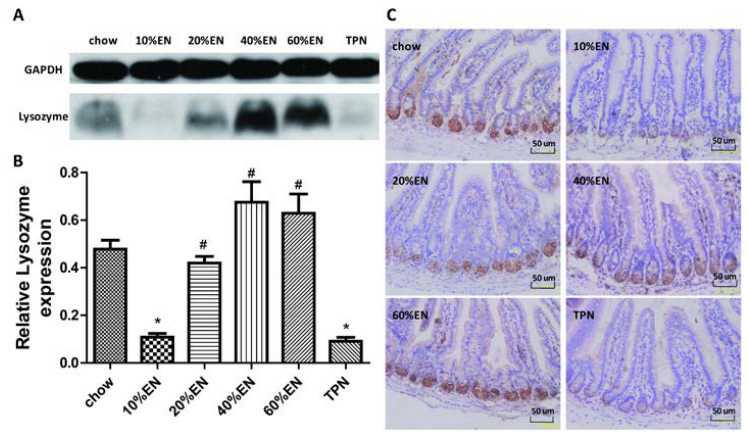
Figure 2. Lysozyme levels in the ileal tissue. ( A ) Lysozyme bands, as detected by Western blot analysis; ( B ) Lysozyme levels in the ileal tissue. Data are presented as the mean ± standard error of the mean (SEM). * p < 0.001 vs. chow. # p < 0.001 vs. TPN; ( C ) Immunohistochemical analysis of lysozyme in each group. Original magnification: ×40. EN: enteral nutrition; TPN: total parenteral nutrition; GAPDH: Glyceraldehyde-3-phosphate dehydrogenase.